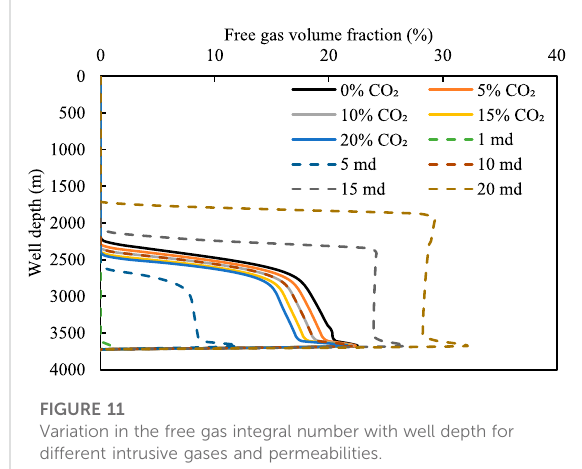
FIGURE 11 Variation in the free gas integral number with well depth for different intrusive gases and permeabilities.